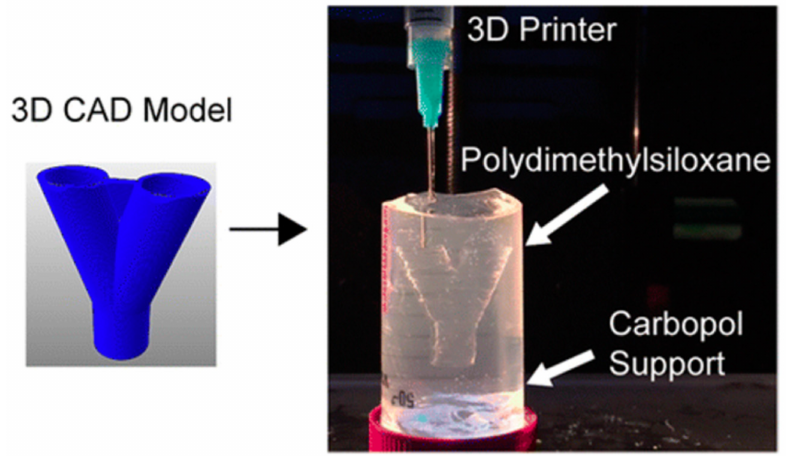
Figure 3. 3DP of hydrophobic polydimethylsiloxane prepolymers inside a hydrophilic Carbopol gel supported by a freeform reversible embedding. Reprinted with permission from Ref [43], Copyright 2016, American Chemical Society.